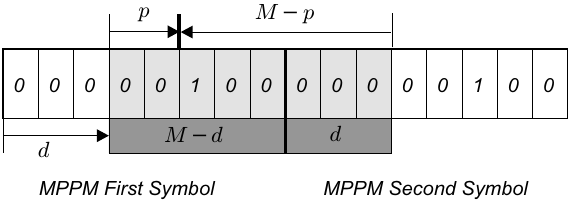
Figure A1. Single chip 1 at position p .